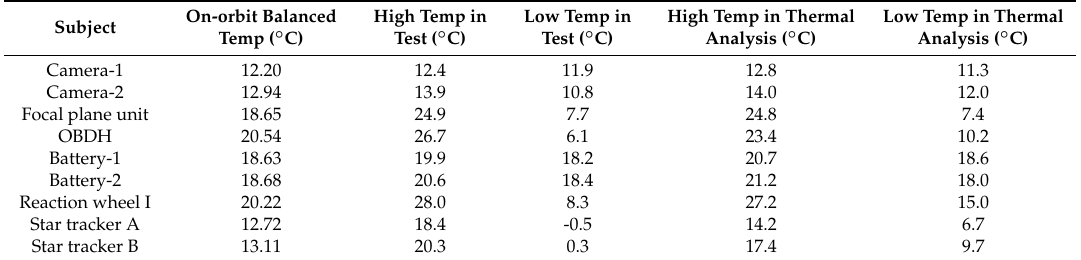
Table 15. Temperature of instruments from on-orbit, ground thermal balanced test and thermal analysis.